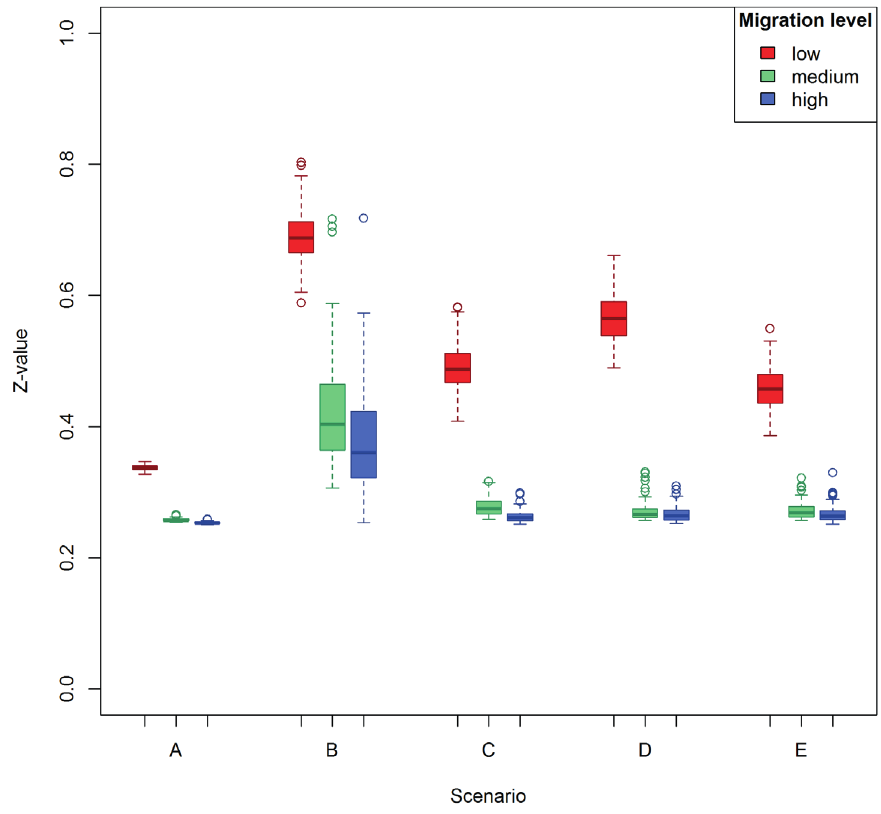
Figure 3 - Boxplots representing the distribution of Z-values (allelic fixation index) for each simulation scenario (different habitat restoration and dispersal capacities), at the final time step of simulation. Colors indicate species’ dispersal capacity (red: G = 1; green: G = 5; blue: G = 10). Scenario A consists in a stable environment (no demographic expansion). Scenarios B and C have the entire domain under habitat restoration, whereas Scenarios D and E have only partial restoration. Scenarios B and D have rapid habitat restoration, while C and E have gradual habitat restoration. Thick horizontal lines in the boxes are medians, and upper and lower boxes represent the upper and lower quartiles respectively. Vertical dashed lines outside boxes represent values up to 1.5 times the interquartile range. Atypical values or outliers (discrepant values) were plotted as individual points outside the